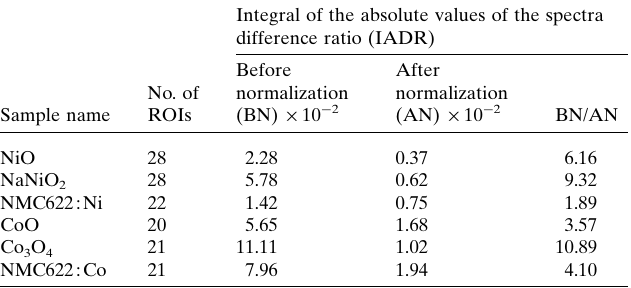
Table 1 Sample list for comparison between MR and AR. Integral of the absolute values of the spectra difference ratio